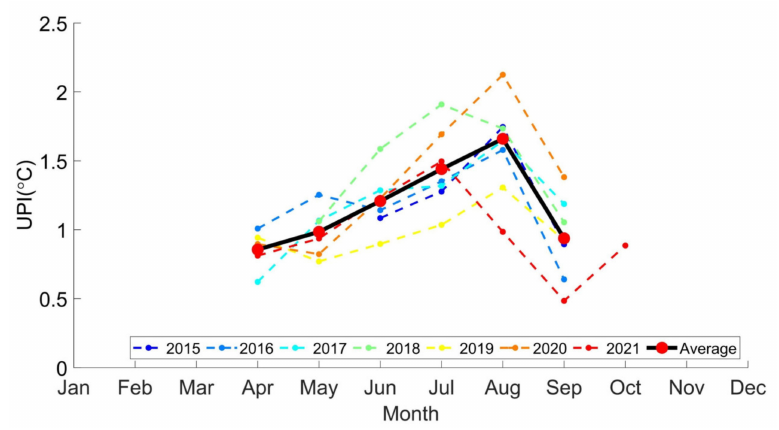
Figure 5. Monthly UPI between July 2015 and December